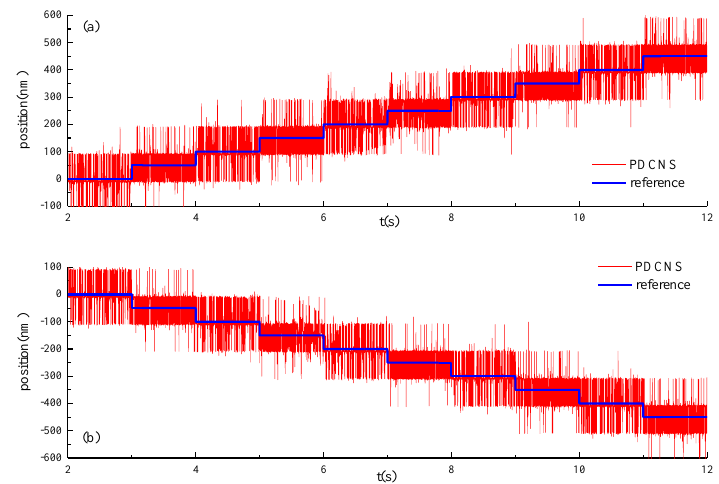
Figure 16. Closed-loop-positioning tests of PDCNS, with step sizes of ( a ) +50 nm ( b ) −50 nm.